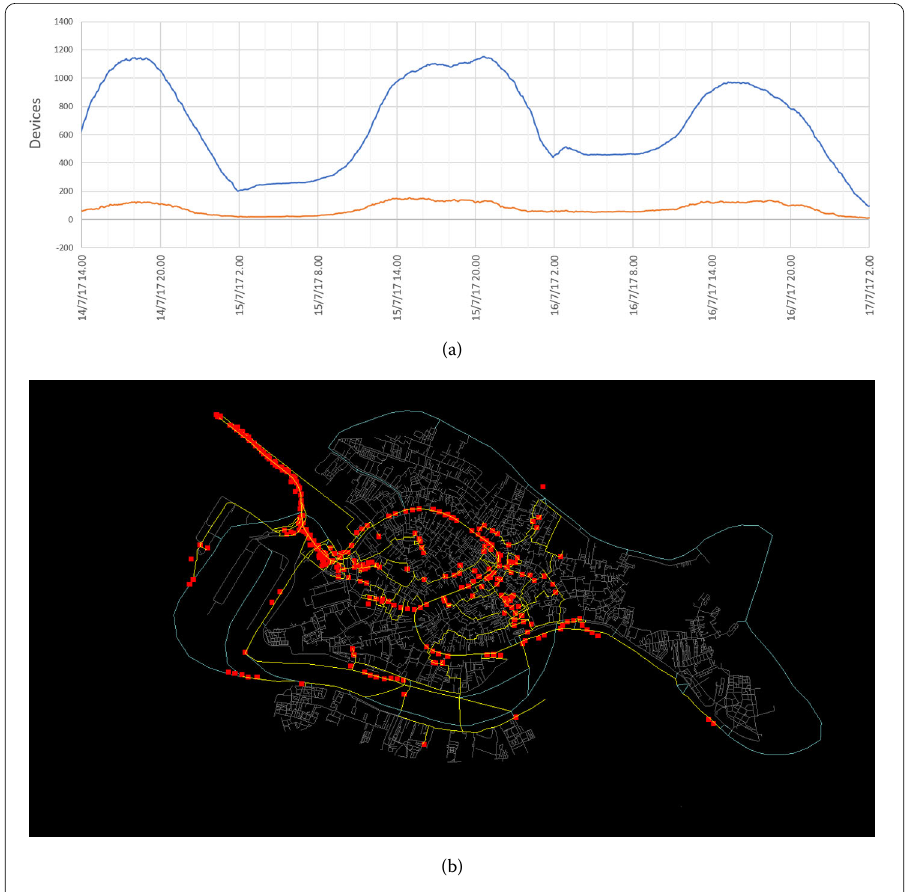
Figure 3 Picture (a): number of selected devices present the FestadelRedentore dataset collected during the three days: we observe the anomalous increase of the presence during the night of 15/7/2017. Picture (b): some examples of mobility paths reconstructed (continuous lines) on the road network of the Venice historical centre using GPS data (red dots)